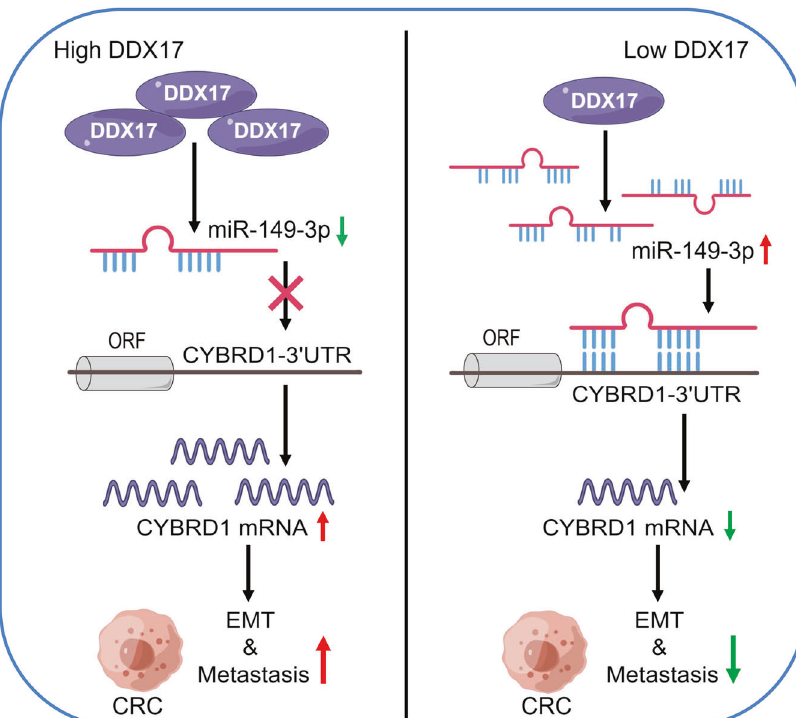
Fig. 7 Schematic diagram of the DDX17/miR-149-3p/CYBRD1 signaling pathway in the modulation of EMT and CRC progression. DDX17 is elevated in CRC and decreases the expression of miR-149-3p independent of DDX17 ’ s Microprocessor function. Downregulated miR-149-3p attenuates its binding to the 3 ′ -UTR of CYBRD1 mRNA, leading to increases CYBRD1 expression and intracellular iron level, which promotes EMT progression and metastasis of CRC